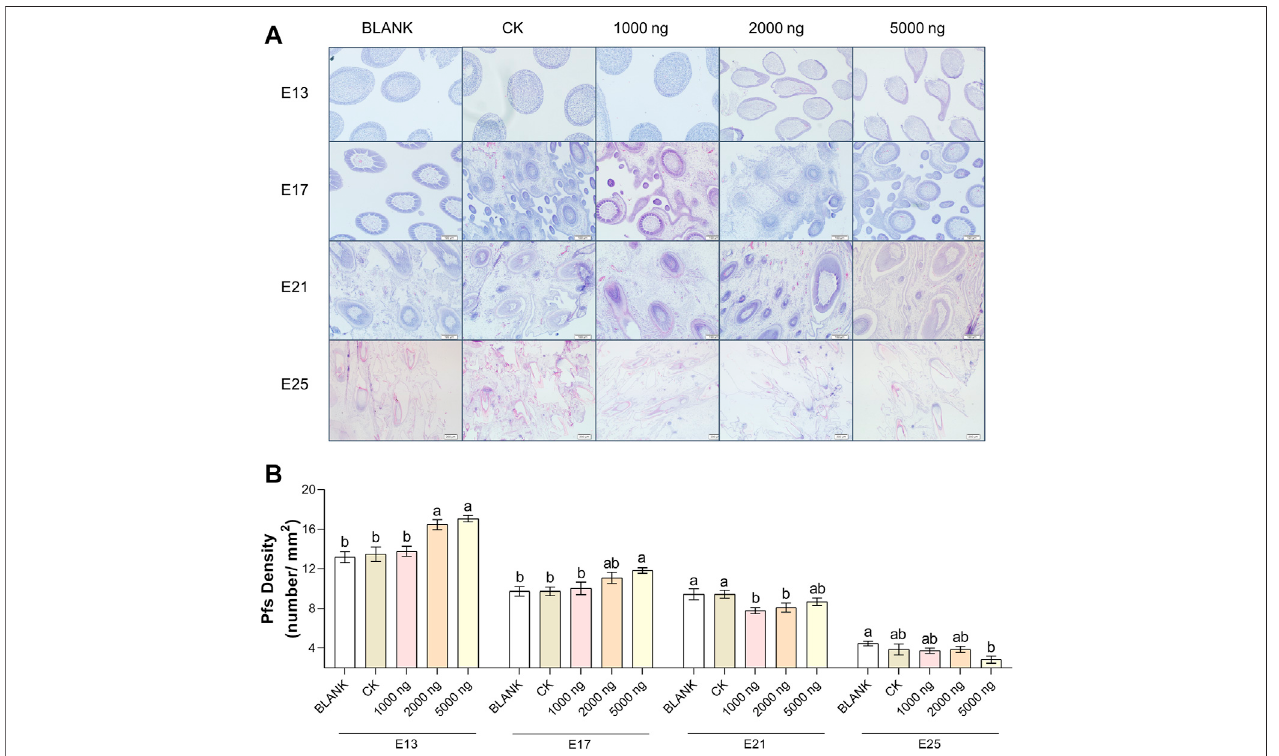
FIGURE 4 | In ovo injection ofCHIR-99021 in goose embryos promotes feather follicle density. (A) Representative images of feather follicle density asindicated by H&E. Bar = 50 μ m at E13 and E17, Bar = 100 μ m at E21 and E25. (B) Primary feather follicle density of each group at E13, E17, E21, and E25. All data are shown as mean±SEMandnocommonsuperscriptletter withinthesame embryonic daymeans statisticaldifference( p < 0.05)byone-wayANOVAwithDuncan ’ smultiple-range test. n = 6